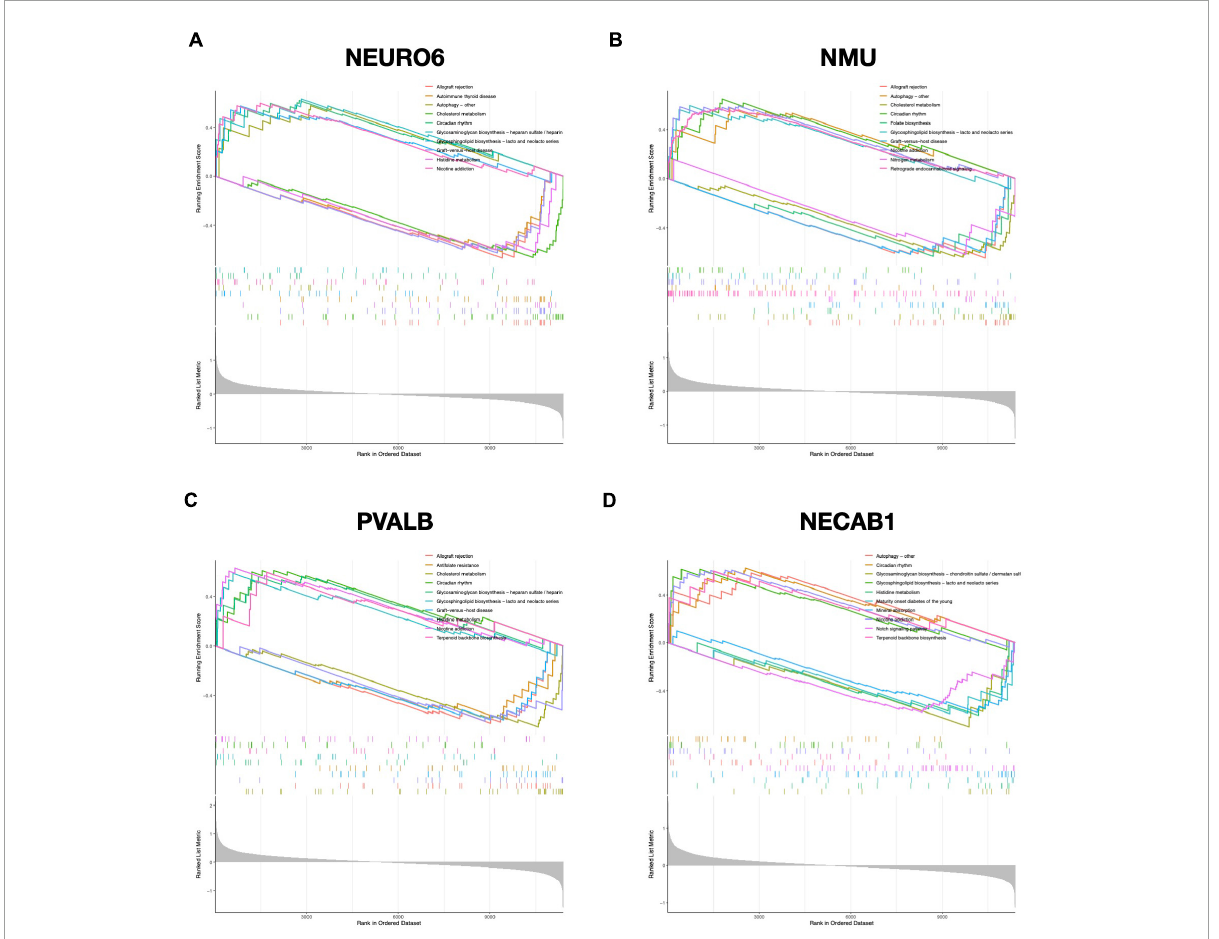
FIGURE8 GSEA analysis of hub genes. Top 5 GSEA enrichment in the high and low expression gene set of (A) NEURO6, (B) NMU, (C) PVALB, and (D)